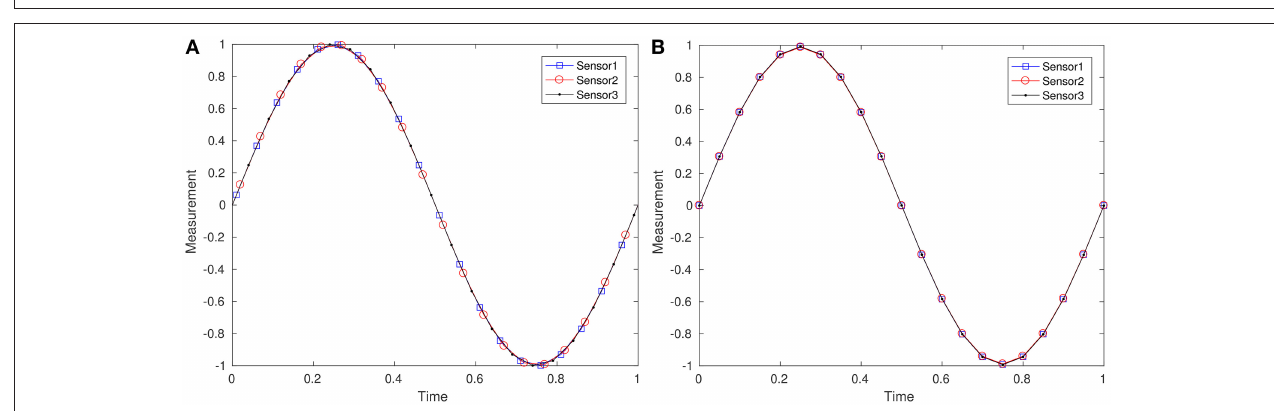
FIGURE 7 | Re-sampling on time-stamped data: (A) before re-sampling with irregular starting times, and (B) after re-sampling.